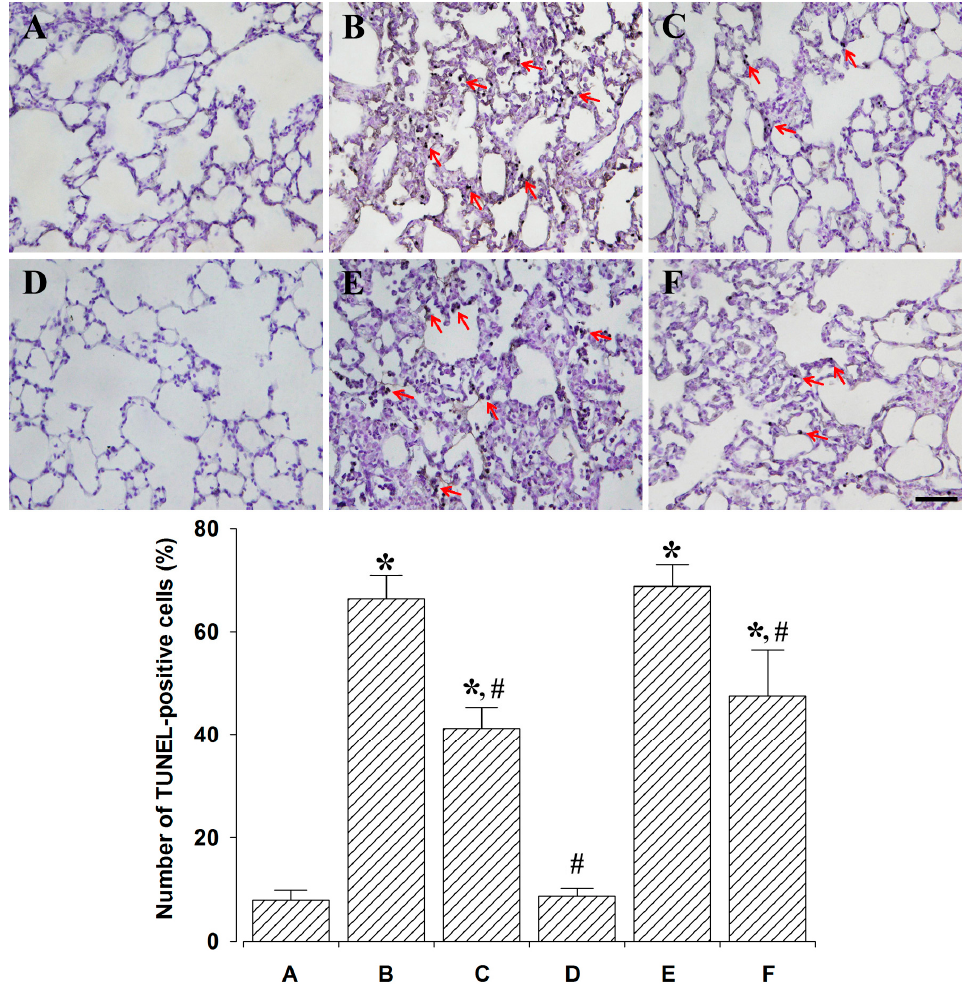
Figure 2. Effect of polydeoxyribonucleotide (PDRN) treatment on the percentage of terminal deoxynucleotidyl transferase-mediated dUTP nick end labeling (TUNEL)-positive cells. Upper : Photomicrographs of TUNEL-positive cells. The scale bar represents 100 μ m. Red arrows represent TUNEL-positive cells. ( A ) Control and 24 h after sacrifice group; ( B ) Lung injury and 24 h after sacrifice group; ( C ) Lung injury with PDRN-treatment and 24 h after sacrifice group; ( D ) Control and 72 h after sacrifice group; ( E ) Lung injury and 72 h after sacrifice group; ( F ) Lung injury with PDRN-treatment and 72 h after sacrifice group. Lower : Percentages of TUNEL-positive cells. * represents p < 0.05 compared to the control and 24 h after sacrifice group. # represents p < 0.05 compared to the lung injury and 24 h after sacrifice group.